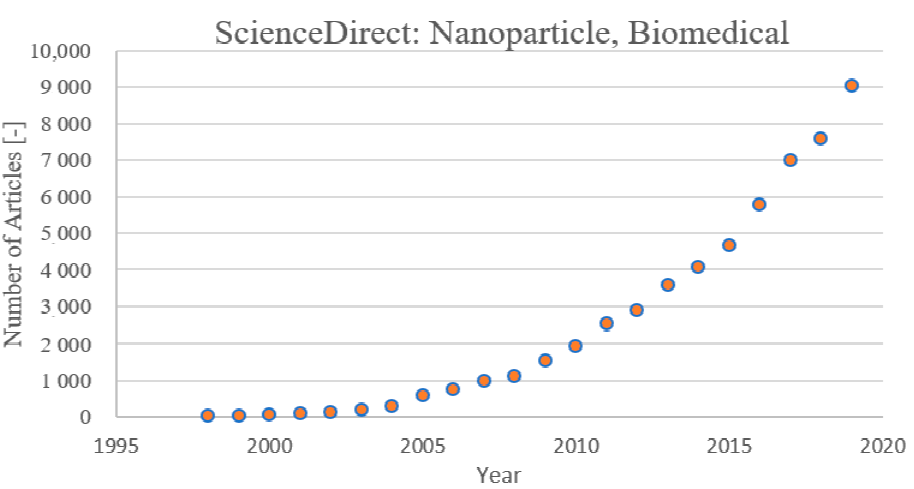
Figure 2. Publications per year on ScienceDirect from 1997 to 2019 on NP application in the biomedical field.